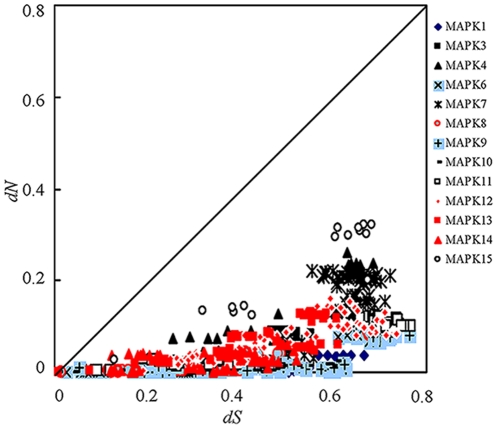
Pairwise comparison plots of dN and dS values for each MAPK subfamily.The dN and dS values were calculated with MEGA4.0. The transition/transversion ratios used for each subfamily are: MAPK1: 2.398; MAPK3: 4.008; MAPK4: 1.428; MAPK6: 2.183; MAPK7: 1.167; MAPK8: 1.132; MAPK9: 1.745; MAPK10: 2.126; MAPK11: 1.706; MAPK12: 1.552; MAPK13: 0.809; MAPK14: 1.803; MAPK15: 1.361.